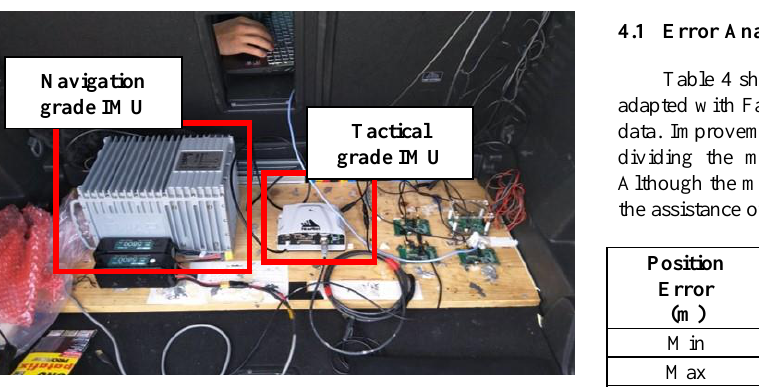
Figure 7. Sensors’ installation in the top view of the vehicle.